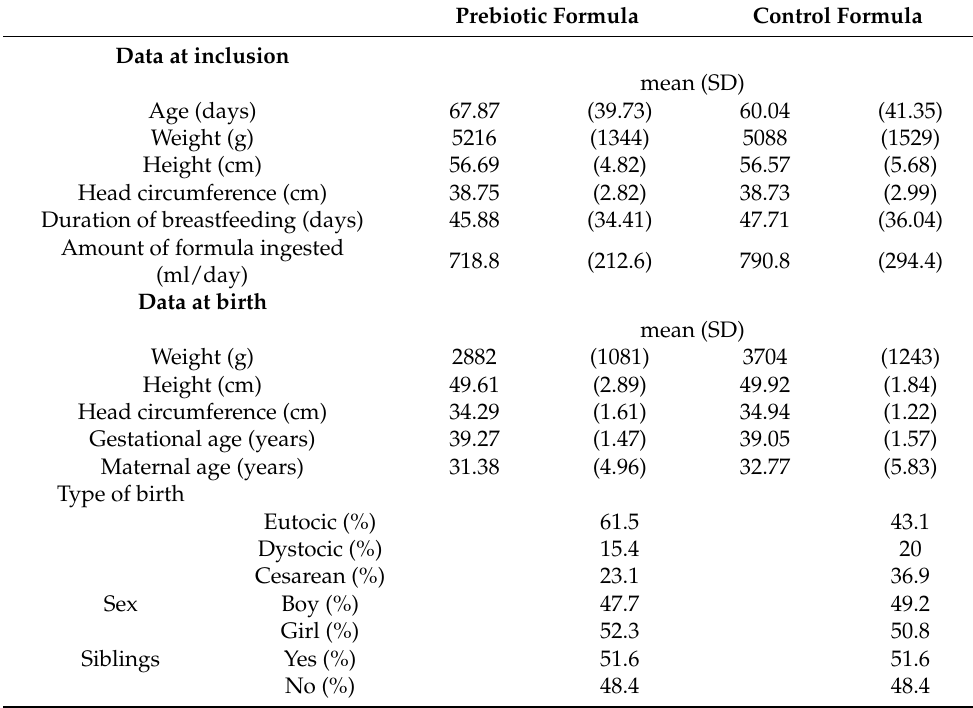
Table 1. Baseline characteristics of the infants enrolled in the